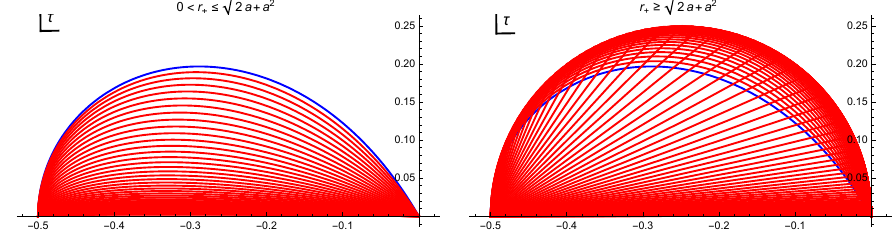
Figure 4 . The blue curve denotes the extremal black hole-locus with the horizon radius r + = p 2 a + a 2 . The red curves correspond to di(cid:11)erent values of r + (where the solution is complex). Notice that the envelope of these complex solutions in H is bounded by the semi-circle on the